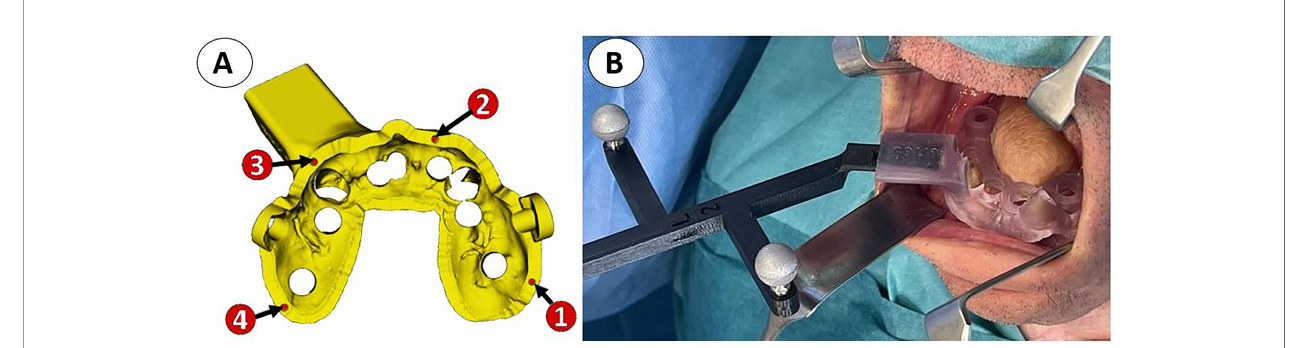
FIGURE 3 | (A) Virtual model of the surgical guide with four pinholes (red) for intraoperative registration and a socket for the attachment of the dynamic reference frame. (B) 3D-printed biocompatible teeth-supported resin guide holding the dynamic reference frame during computer-assisted surgery in a right hemotingue